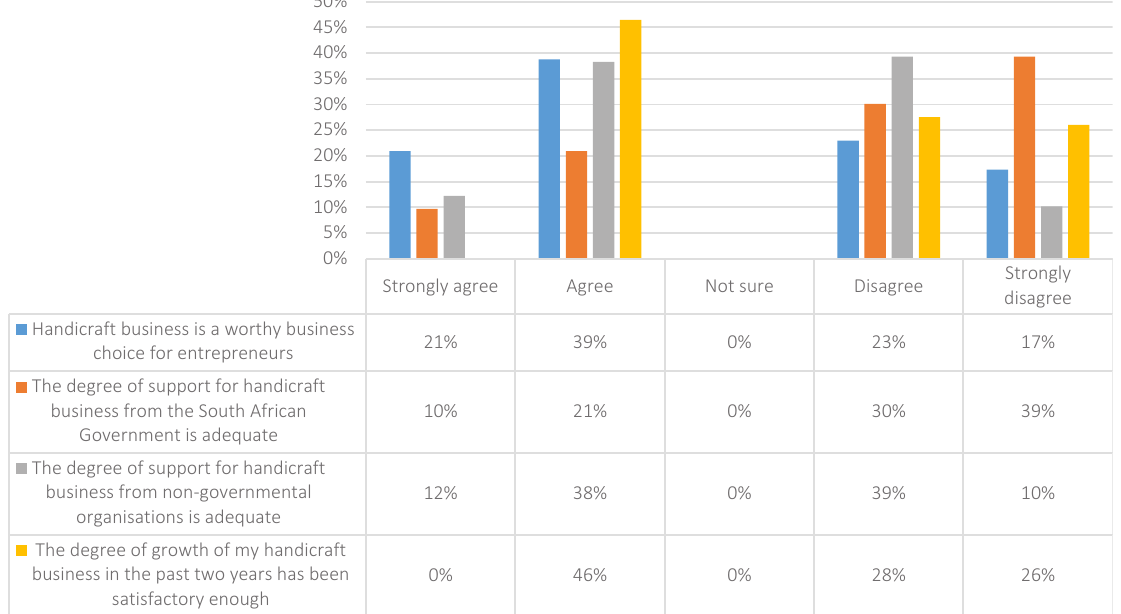
Strongly agree Agree Not